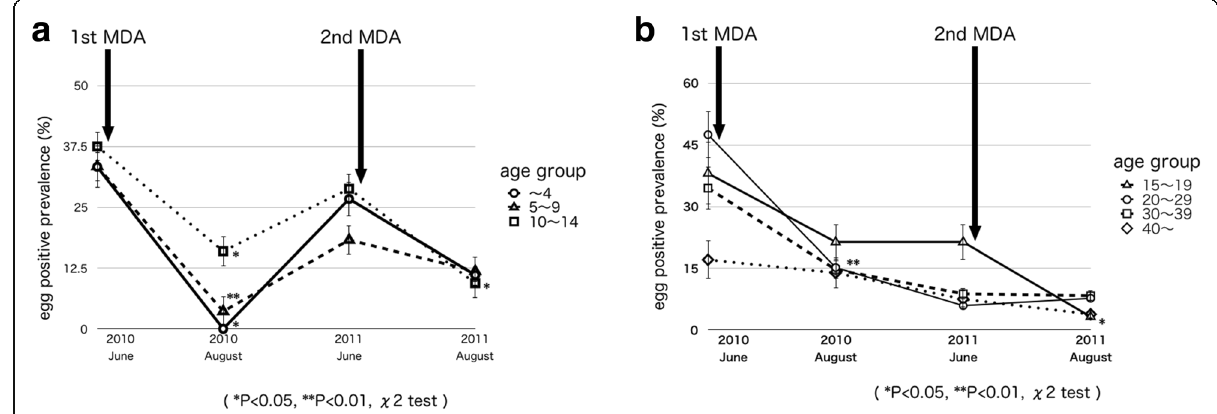
Fig. 2 a Process of egg-positive rate by age group 2010 – 2011. b Process of egg-positive rate by age group 2010 –